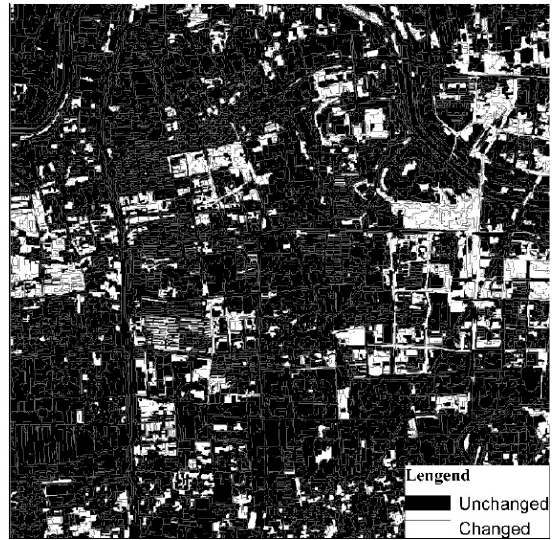
Figure 14. Change binary map for land cover detection based on SCCD.